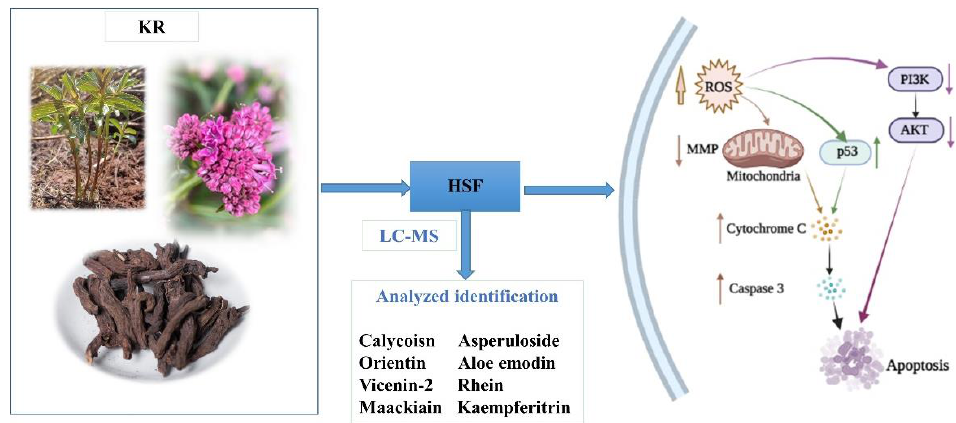
Figure 7. Pathway of apoptosis induced by HSF in MCF-7 cells.